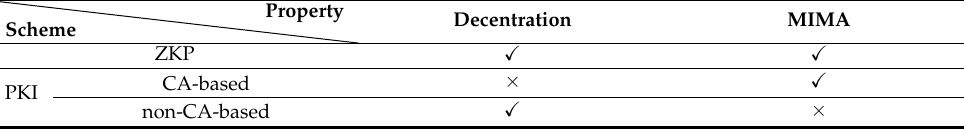
Table 5. Comparison between ZKP-based authentication and PKI-based authentication.